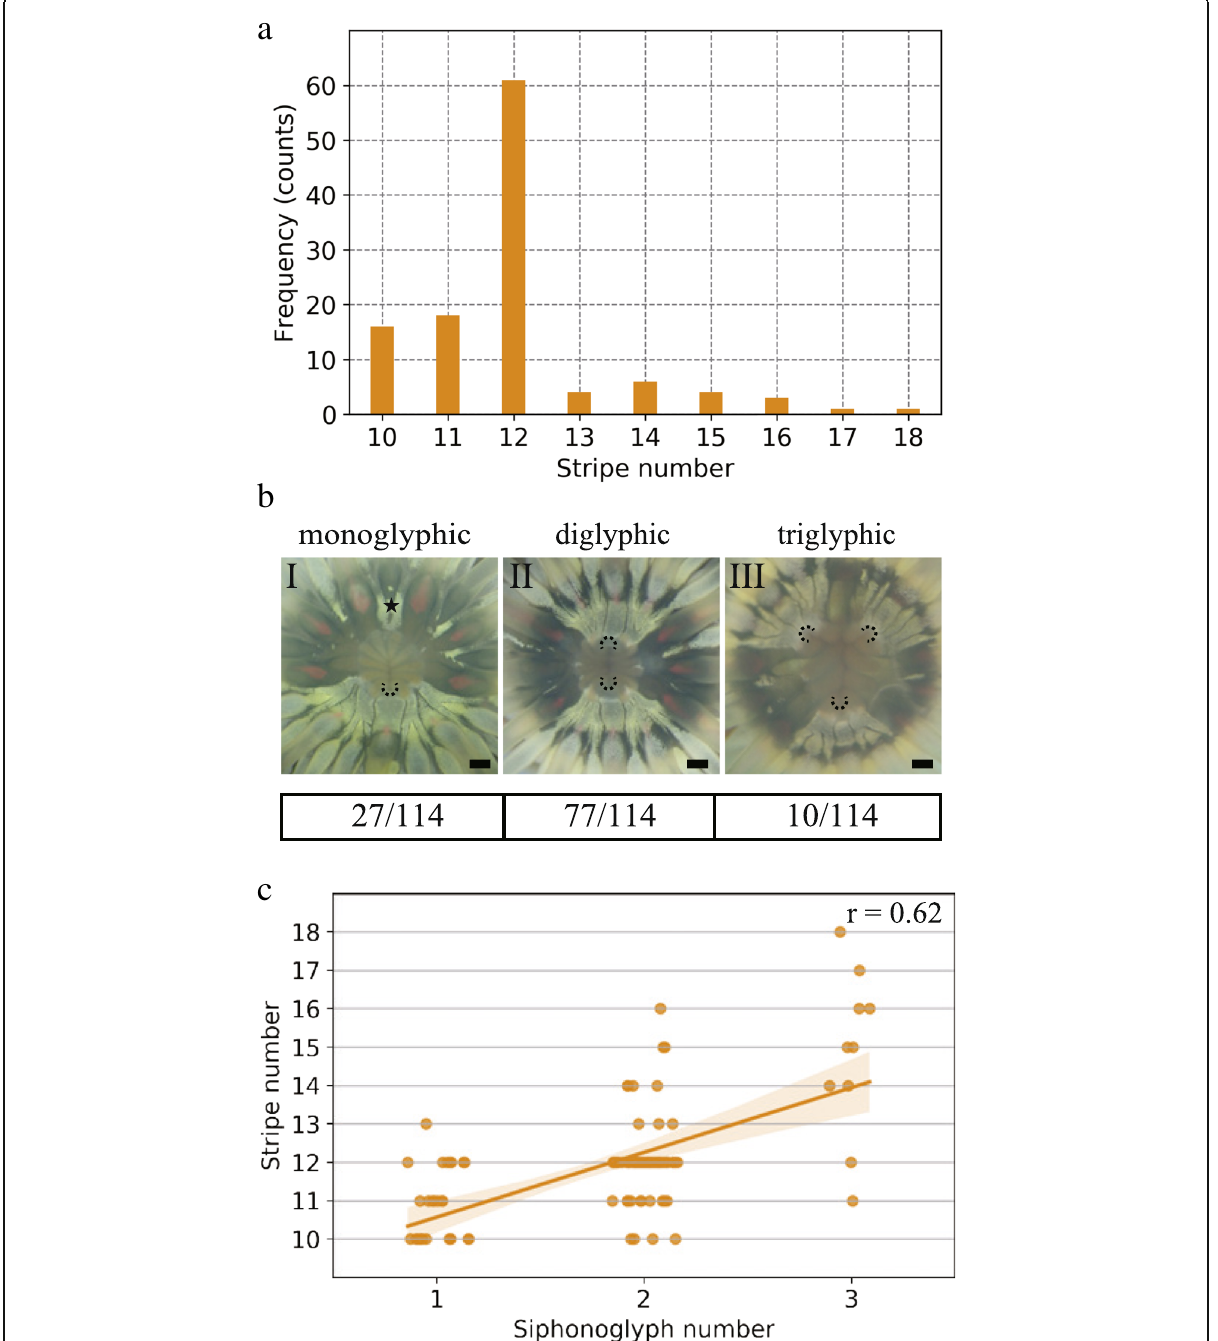
Fig. 3 Correlated variation of gastric pouch and siphonoglyph numbers in D. lineata . a Frequency of individuals as a function of the number of orange stripes corresponding to first, second, and directive gastric pouches. b Representative examples (upper panel) and frequency of monoglyphic (I), diglyphic (II), and triglyphic (III) individuals . Black dashed arcs indicate siphonoglyphs. Numbers at the bottom of each panel denote the number of individuals, n = 114. The star mark indicates intermittent white pigmentation unrelated to the siphonoglyph position. Scale bars, 500 μ m. c Scatter plot of the stripe number as a function of the siphonoglyph number with the Pearson correlation coefficient r p , where x, y, and Σ denote the number of siphonoglyphs, that of stripes, and the summation for the observed individuals, ¼ N ð Σ xy Þ − ð Σ x Þð Σ y Þ ffiffiffiffiffiffiffiffiffiffiffiffiffiffiffiffiffiffiffiffiffiffiffiffiffiffiffiffiffiffiffiffiffiffiffiffi ½ N Σ x 2 − ð Σ x Þ 2 (cid:2)½ N Σ y 2 − ð Σ y Þ 2 (cid:2) respectively. Data sets are identical among a –